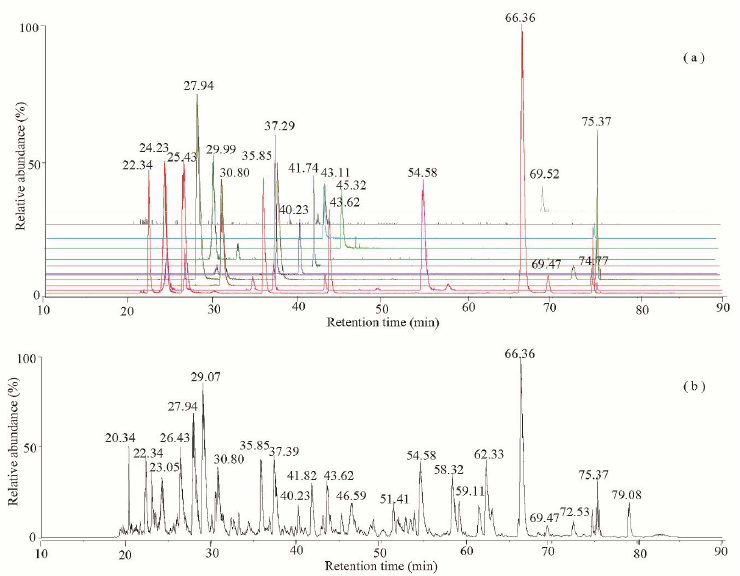
Figure 7. Ion chromatograms of the trypsin-treated 4HA13. Proteins were identified using LC MS/MS at a duration of 90 min. ( a ) Extracted ion chromatograms of the high abundance peptides of the top twelve proteins followed by the order of major capsid protein (gi|1735348871, red), tail tape measure protein (gi|1735348880, pink), tail sheath protein (gi|1735348876, orange), hypothet- ical protein AC4HA13_0057 (gi|1735348866, dark yellow), hypothetical protein AC4HA13_0041 (gi|1735348850, purple), tail tube initiator protein (gi|1735348882, blue), hypothetical protein AC4HA13_0070 (gi|1735348883, dark cyan), tail completion protein (gi|1735348875, oliver), baseplate wedge protein (gi|1735348886, green), tail tube protein (gi|1735348877, cyan), hypothetical protein AC4HA13_0076 (gi|1735348889, gray), and hypothetical protein AC4HA13_0049 (gi|1735348858, light gray). ( b ) Total ion chromatogram of a tryptic digest of